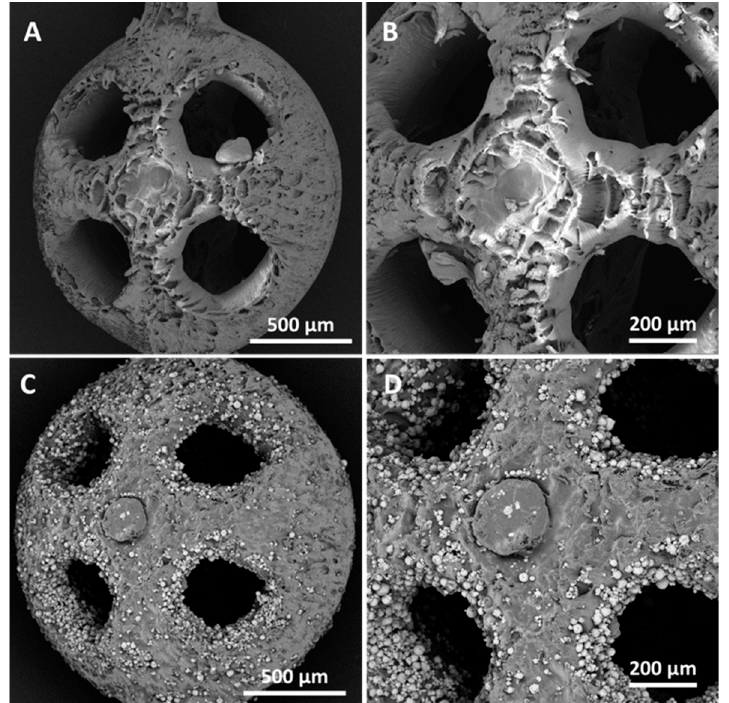
Figure 5. SEM images of the beads (d bead = 2 mm and d hole = 500 µm) manufactured by vat photopolymerization with acrylic acid ester, both unreinforced ( A , B ) and reinforced with 10% HA ( C , D ). The SEM micrographs in ( B ) and ( D ) show the details at higher levels of magnification.